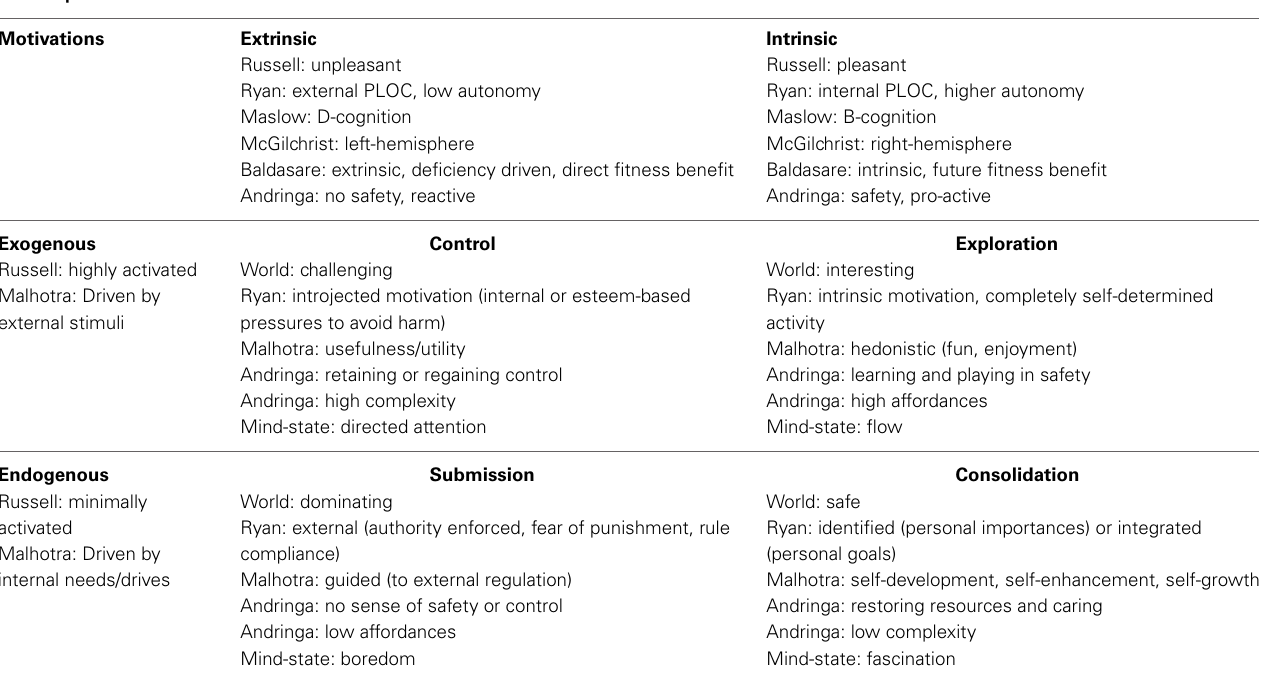
Table 2 | Four motivational states.